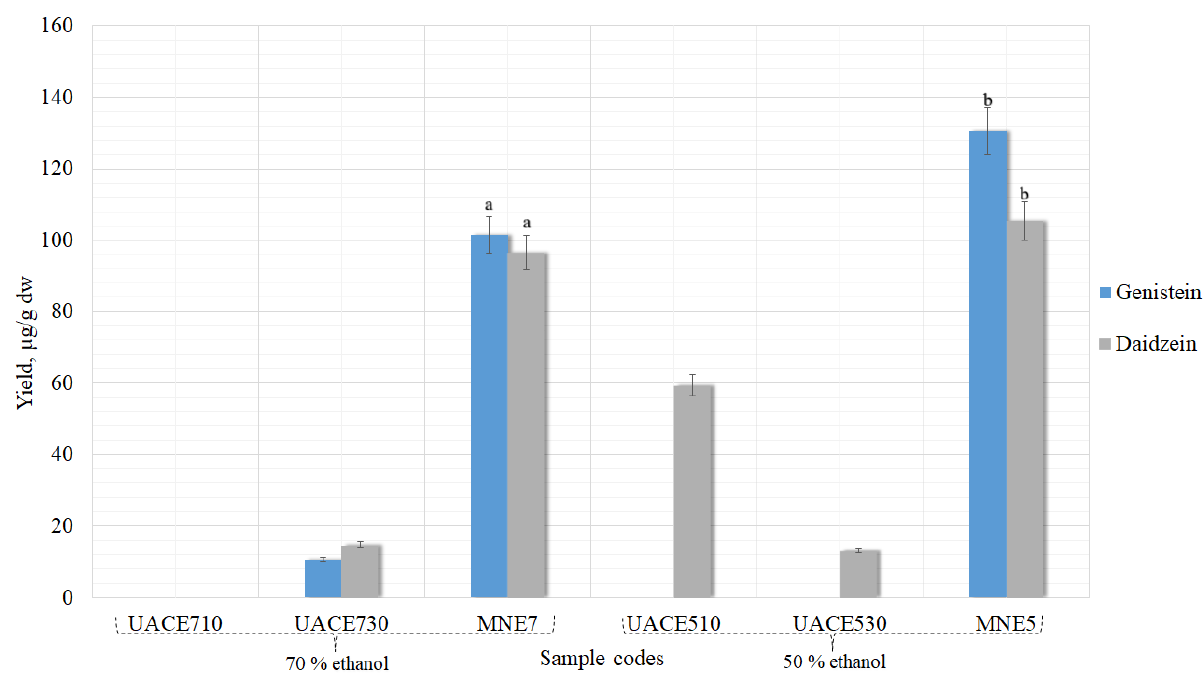
Figure 5. Influence of UAE treatment time and solvent concentration with acidic hydrolysis on the maximal extraction yield of genistein and daidzein in extracts. a p < 0.05 vs. maceration with 50% ethanol (MNE5); b p < 0.05 vs. maceration with 70% ethanol (MNE7). Sample codes and preparation conditions are displayed in Table 1.